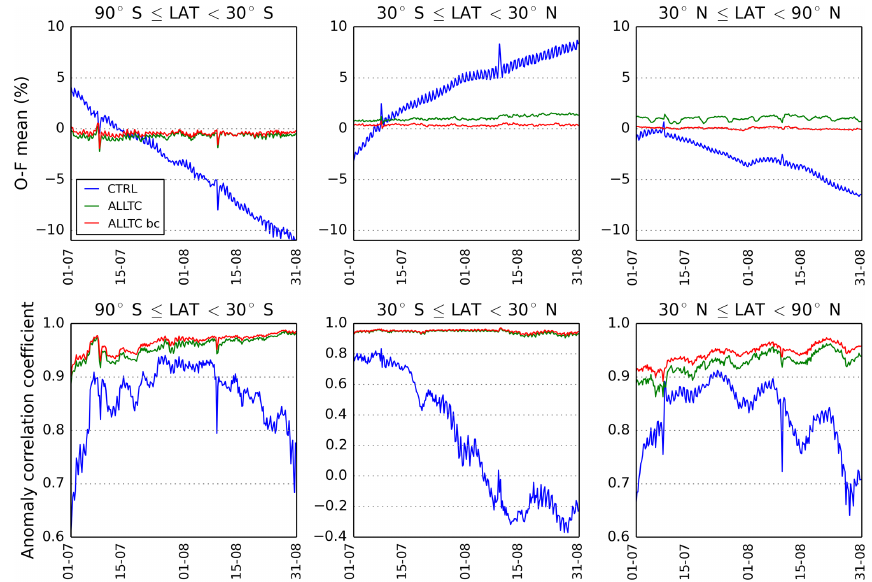
Figure 9. Zonal mean differences (%) and anomaly correlation coefficients (unitless) for total column ozone between OMI-TOMS observa- tions and short-term forecasts as a function of time (date). Results are shown for the case without assimilation as well as with the assimilation of OMI, GOME-2A/B, and OMPS-NM (both with and without bias correction). The legend indicates the assimilation run (see Table 5 for description). Each value plotted was calculated using a 24h time